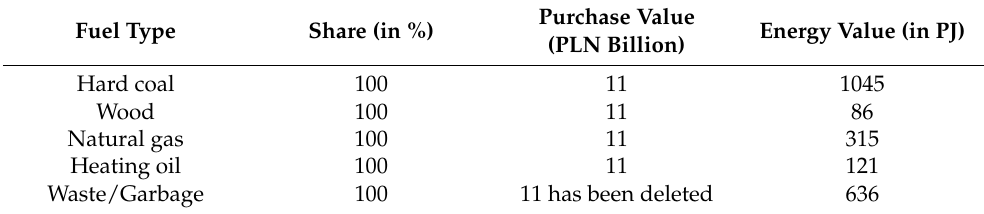
Table 1. Estimation of the energy value of the alternative fuels, assuming that all income is spent on the purchase of one type of fuel only compared to the energy value obtained from